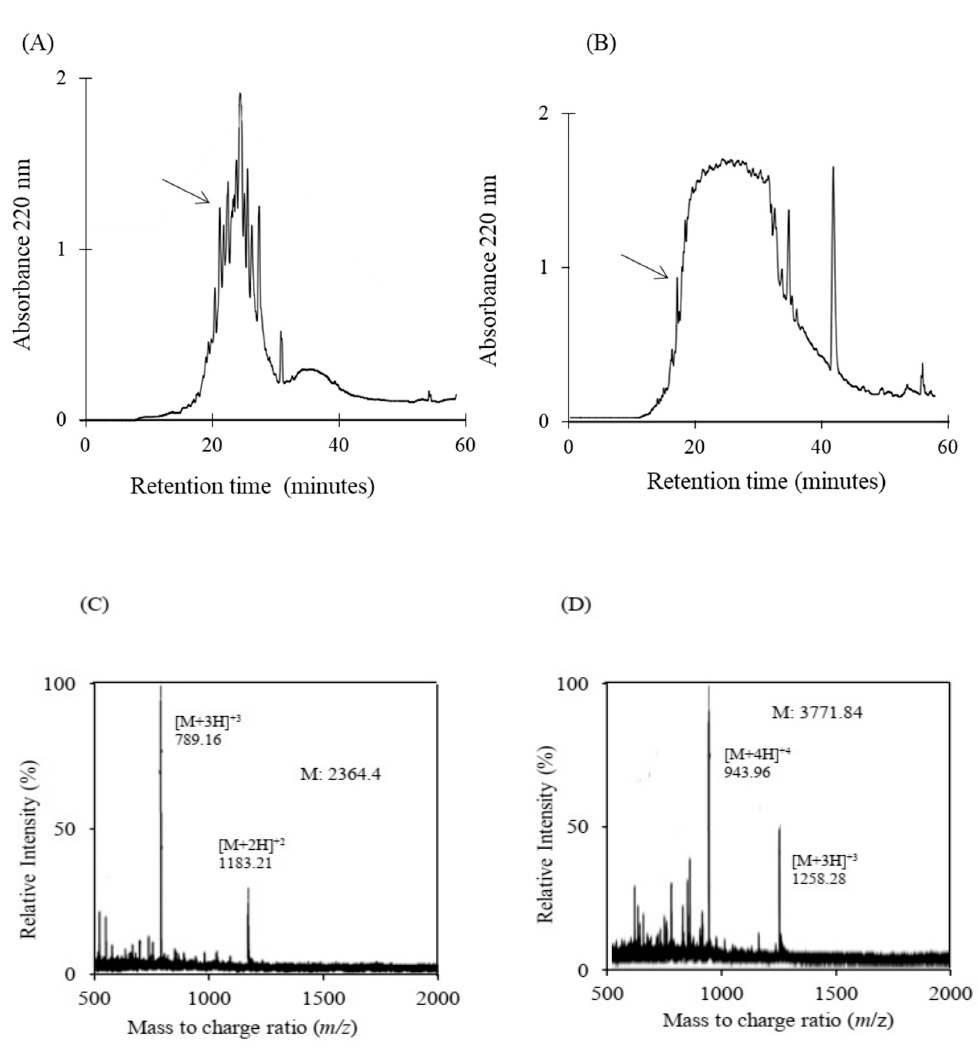
Figure 1. Purification and identification of the bioactive peptides from fish and beef. Chromatographic profiles of the fish and beef hydrolysates obtained by RP-HPLC using a dC18 column ( A and B , respectively). The peaks marked by arrows show the target peptides termed F21 and B34. ESI-TOF mass spectra showing multiple charged molecular ions of the peptides F21 and B34 ( C and D , respectively). The molecular masses of F21 and B34 were calculated based on the most abundant peaks.